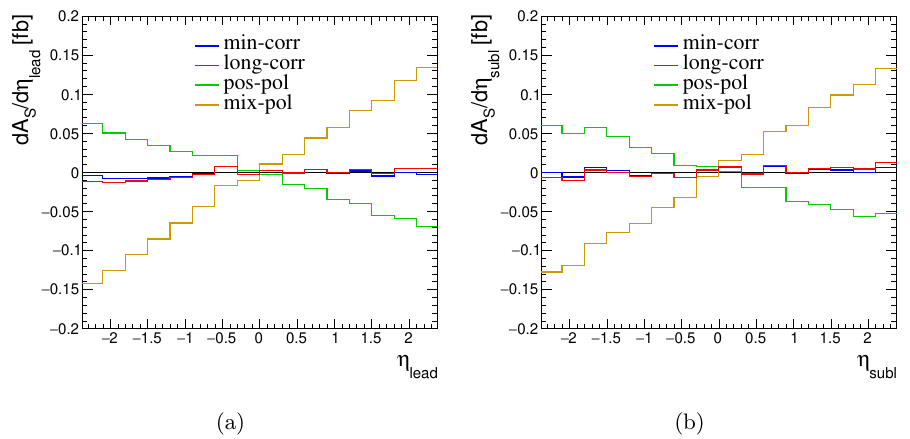
Figure 15 . The asymmetry constructed from the rapidity slicing as de(cid:12)ned in (4.3), similar analogous to (cid:12)gure 5, as a function of leading muon rapidity (left) or subleading muon rapidity (right). Here with HL muons within the phase space (5.1).